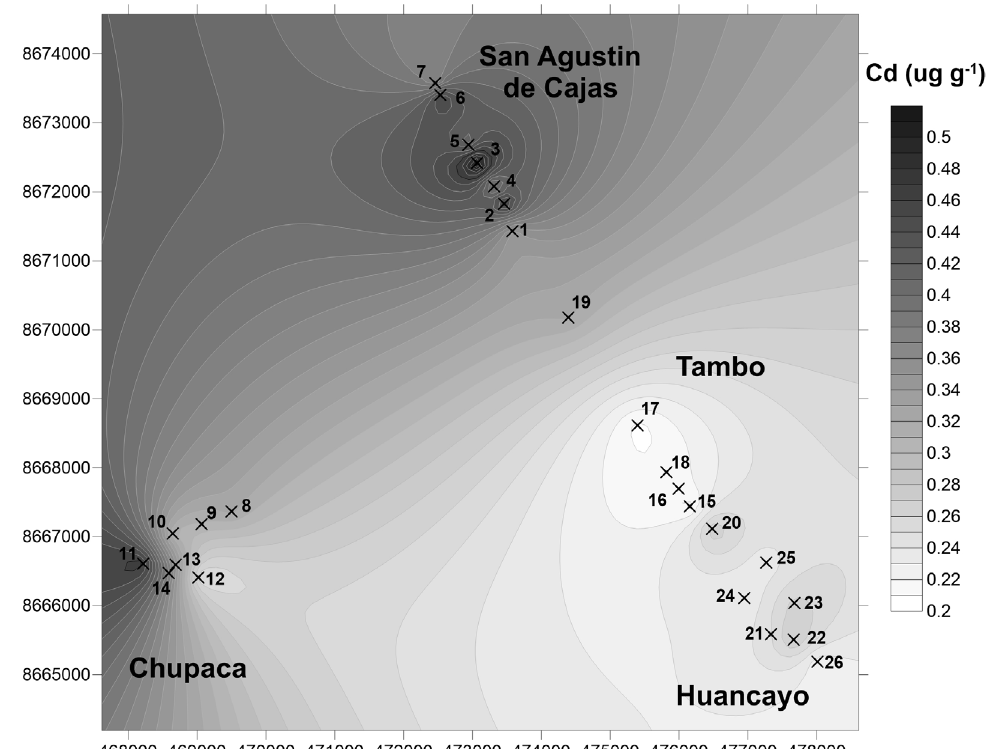
Figure 4. Distribution map of Cd